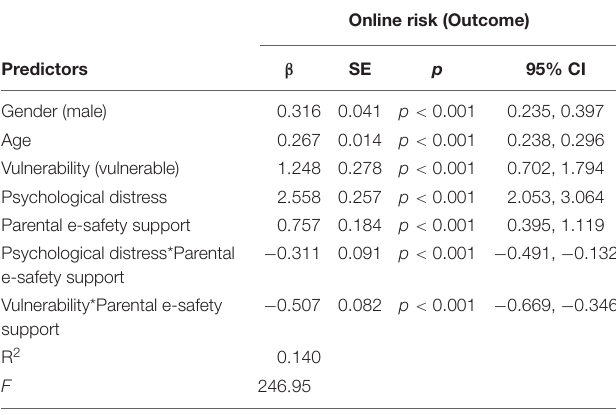
TABLE 4 | Moderated mediational analysis examining the role of parental e-safety support as a moderator of the relationship between vulnerability and online risk, and between psychological distress and online